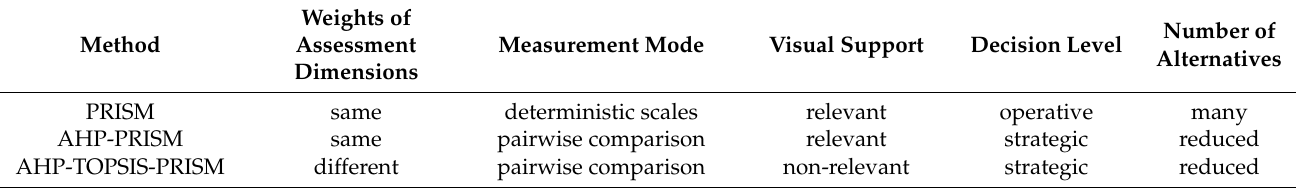
Table 10. Criteria for method